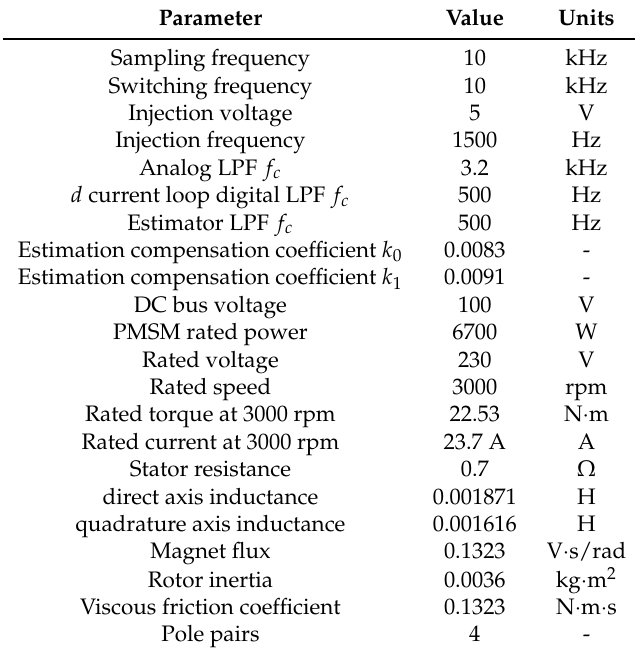
Table 2. Main parameters of the system.